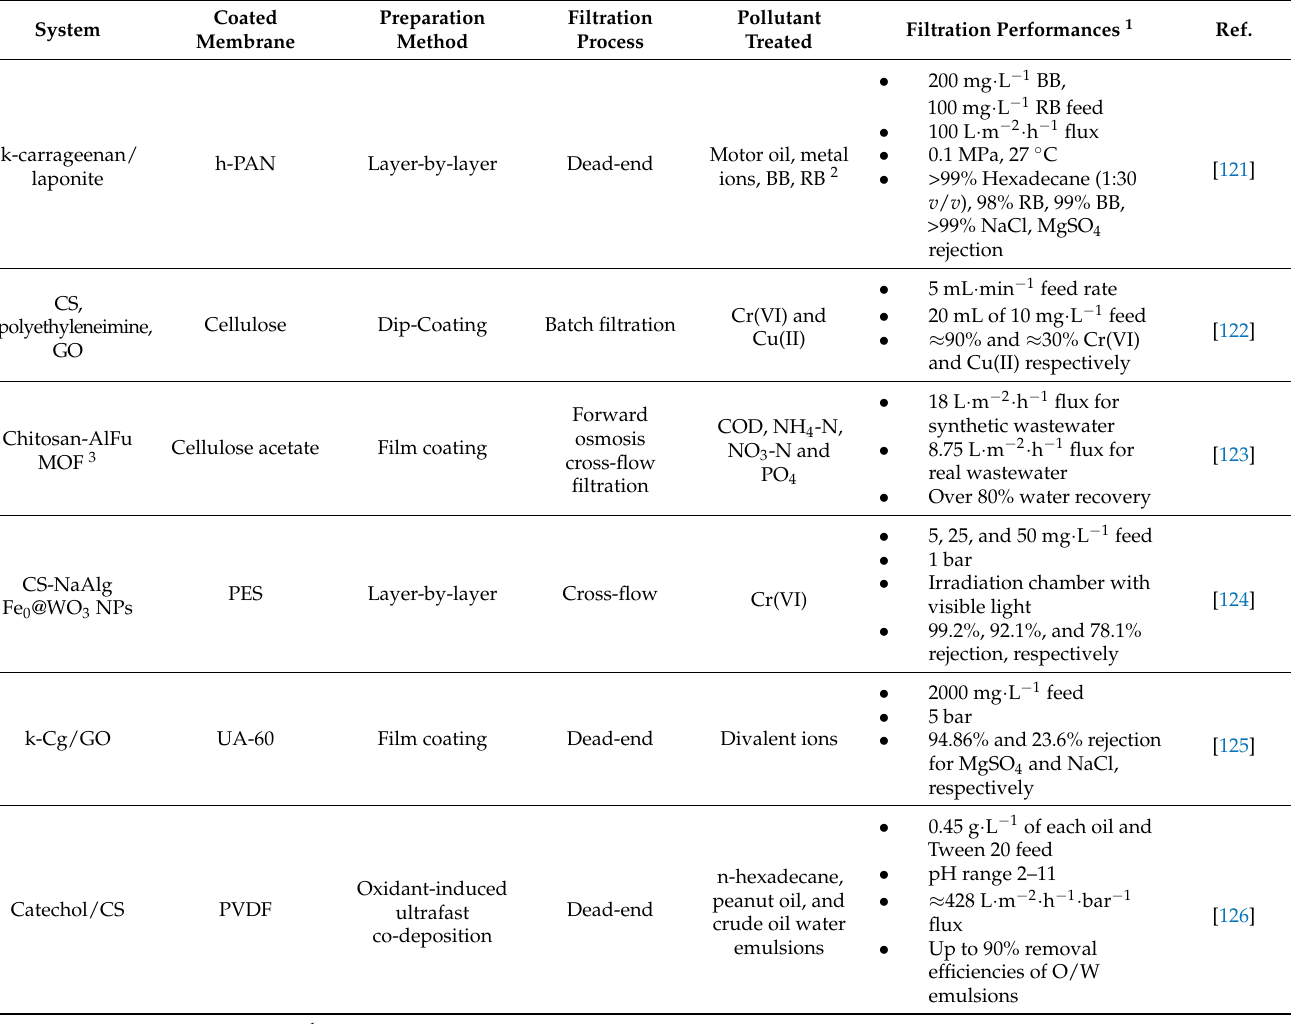
Table 4. Explicative table with reported a comparison of the most recent developed sustainable and functional coatings for filtration